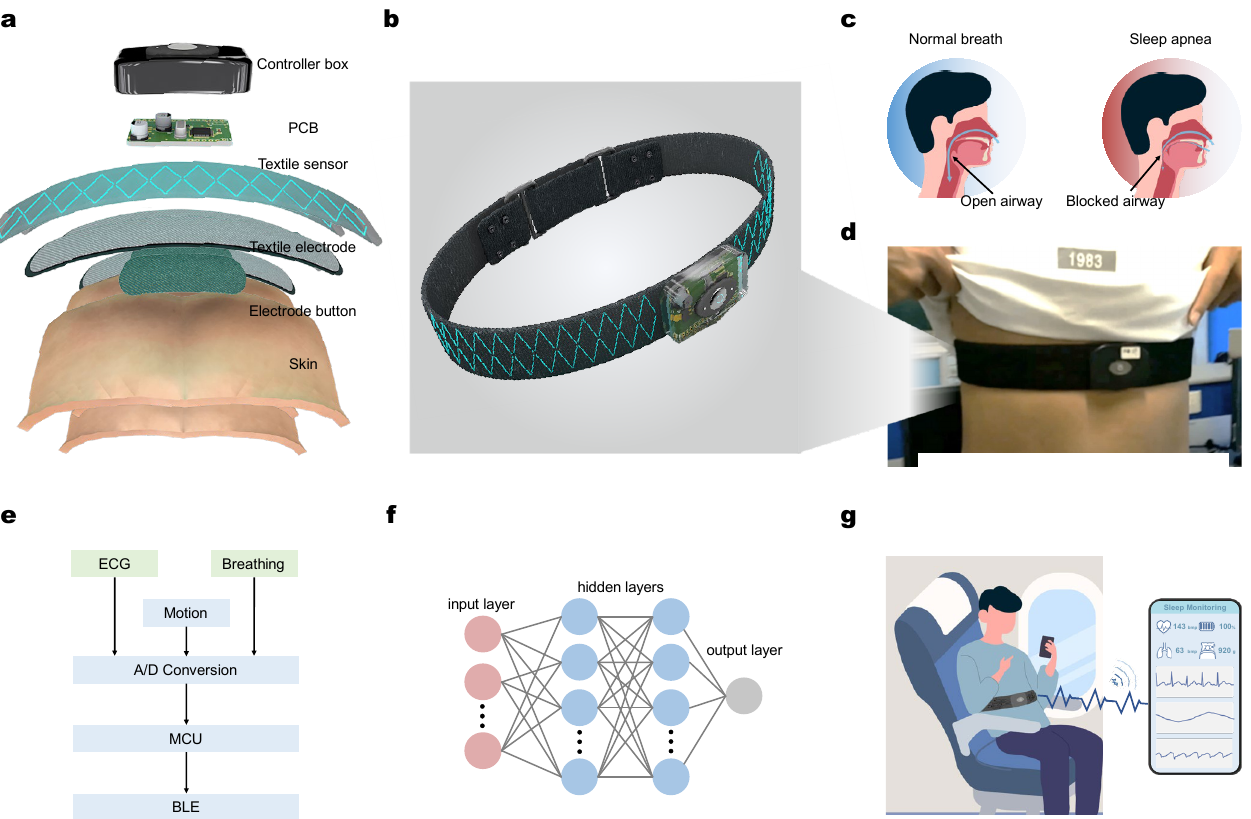
Figure 1. Airline point-of-care system on seat belt. ( a ) Illustration of the layered hardware structure of our designed chest band and ( b ) the fabricated chest band device. ( c ) Aspiration difference between normal breath and sleep apnea caused by airflow. ( d ) Physical photos of the chest belt on a human subject. ( e ) Working flowchart of the monitoring system with hardware and software. ( f ) Neural network that applied in the system as a classifier. The red nodes represent input layer, the blue nodes represent hidden layers, and the gray node represent the output layer in the network. ( g ) Schematic of airline point-of-care monitoring system in the user’s client with Bluetooth-based data transmission to the mobile terminal for hybrid physiological signal